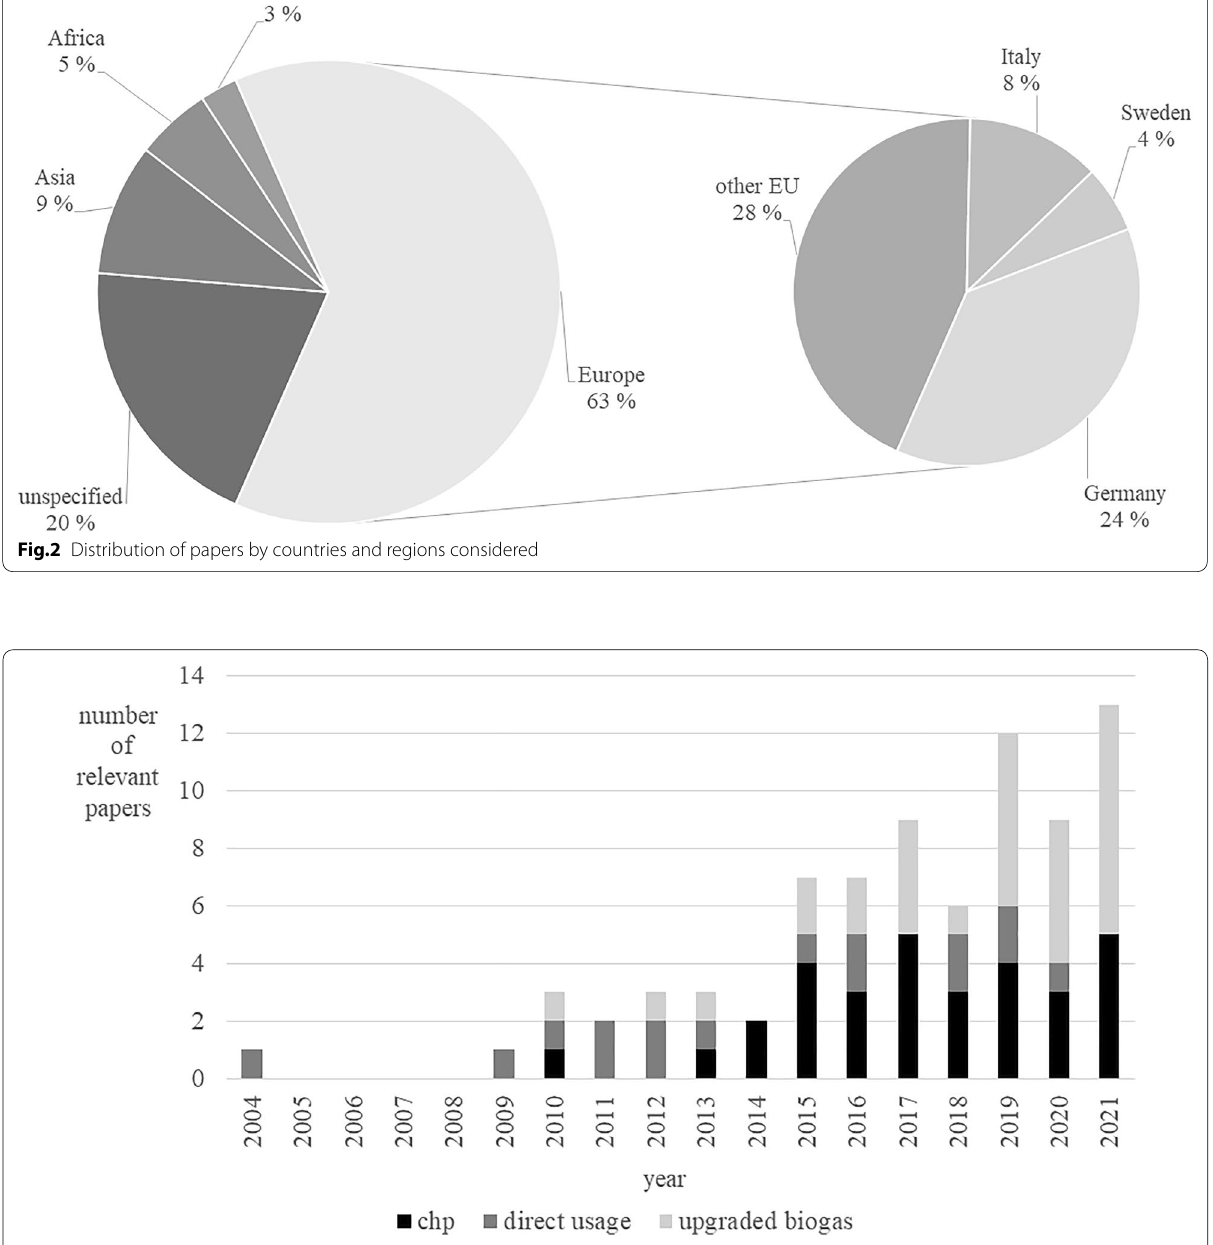
Fig. 3 Development of relevant published papers by utilization pathway over